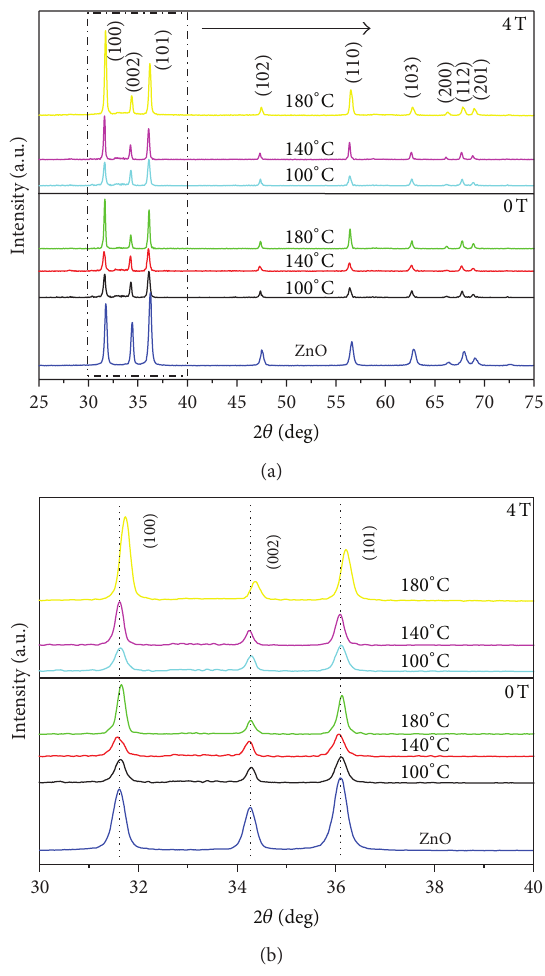
Figure 2: The XRD patterns of the